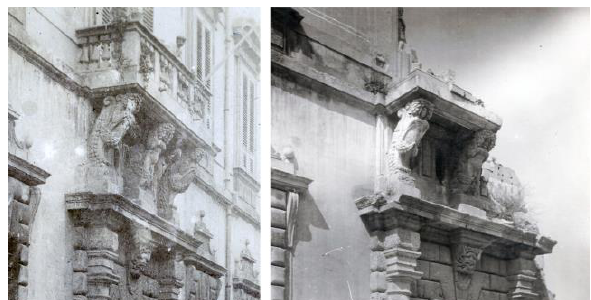
Figure 13 . The balcony before and after the earthquake.